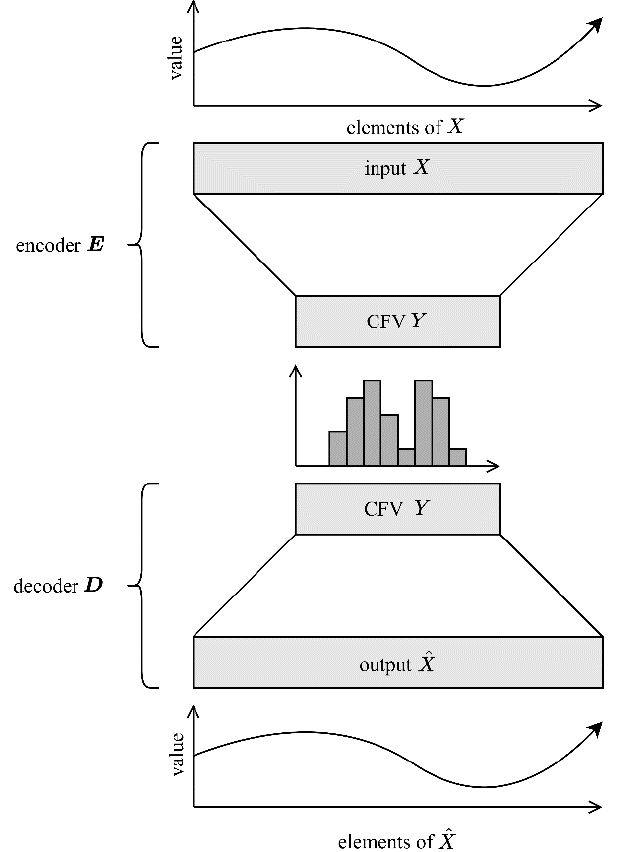
Figure 2. The encoder–decoder (ED) consists of two neural networks trained in unity to output ˆ X from X while information must pass the compressed feature vector (CFV).